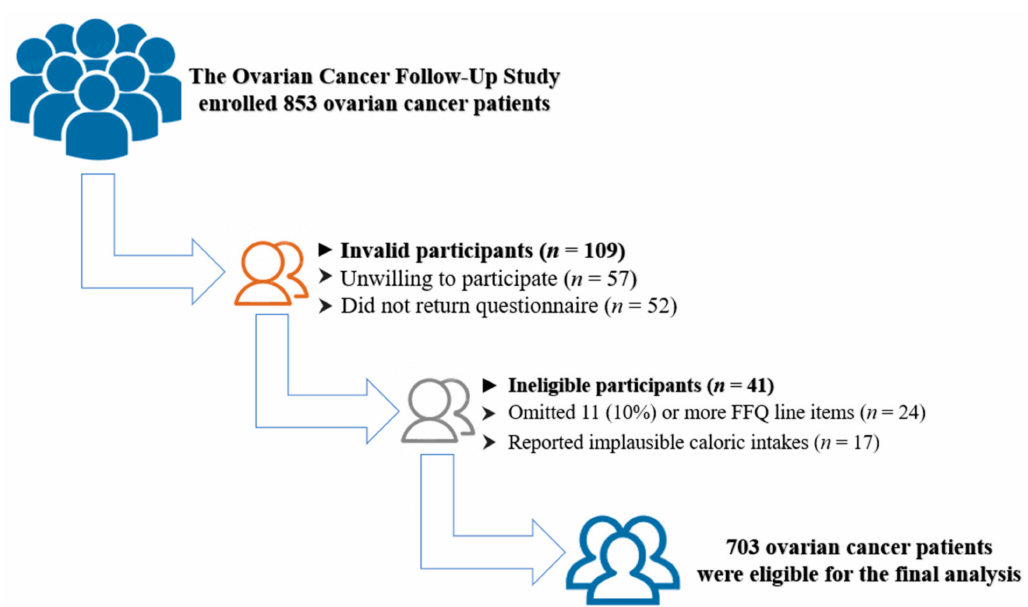
Figure 1. Flow diagram of the selection of